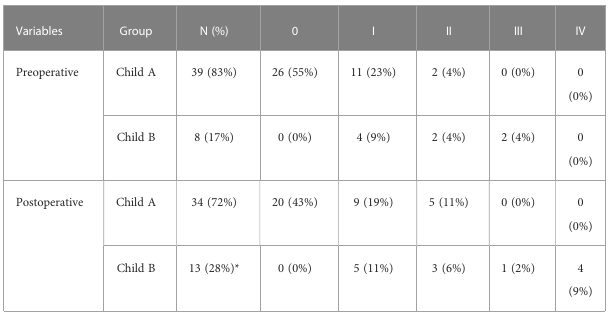
TABLE 4 Dynamic changes in liver function after oncolytic viral